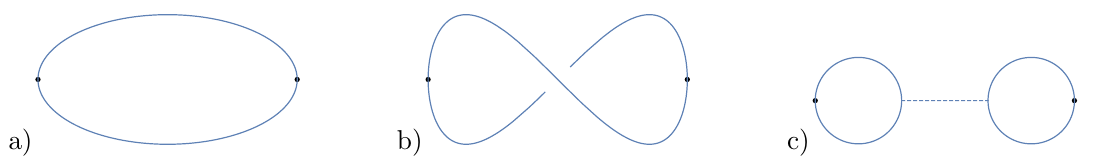
( x ) J (cid:13)(cid:14) ( x 0 ) i and h T (cid:22)(cid:23) ( x ) T (cid:21)(cid:26) ( x 0 ) i